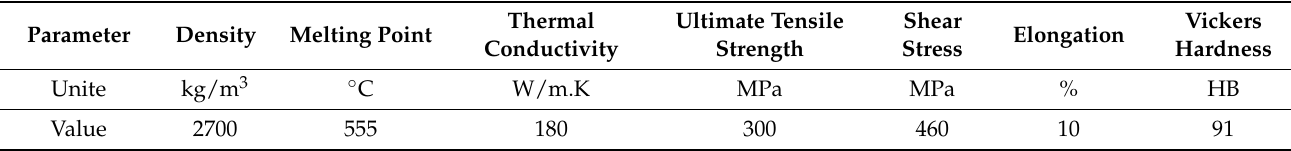
Table 1. AA6082 aluminum alloy mechanical properties.